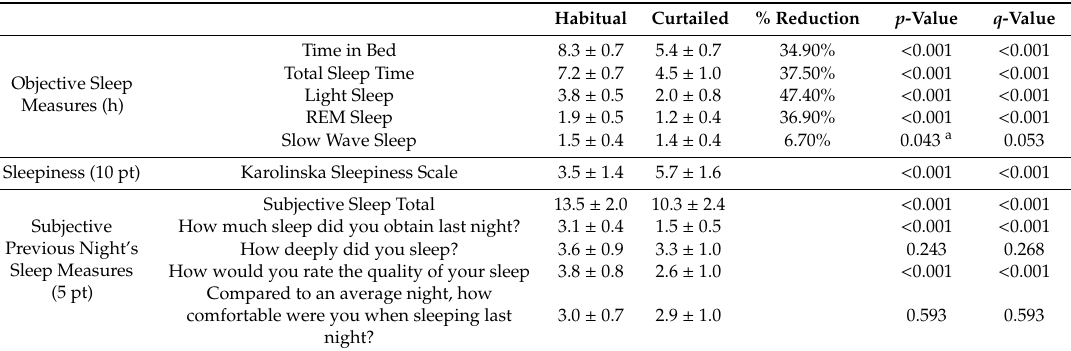
Table 3. Summary of objective and subjective sleep